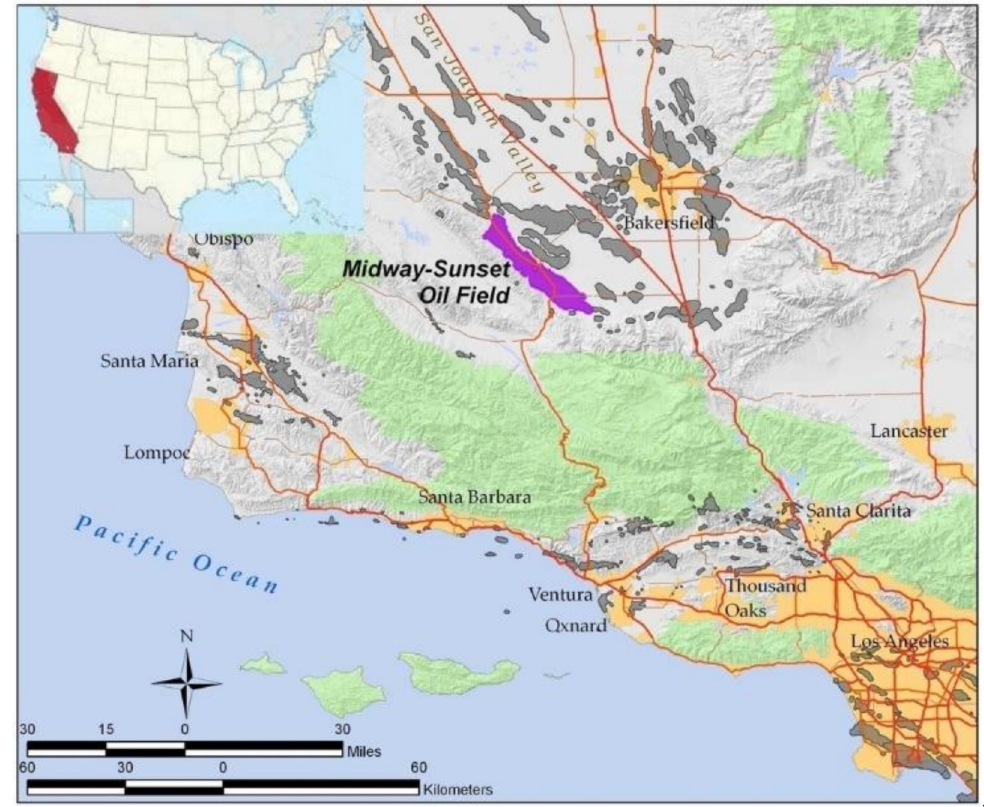
Figure 1. The Midway-Sunset oil field in the southeast to northwest